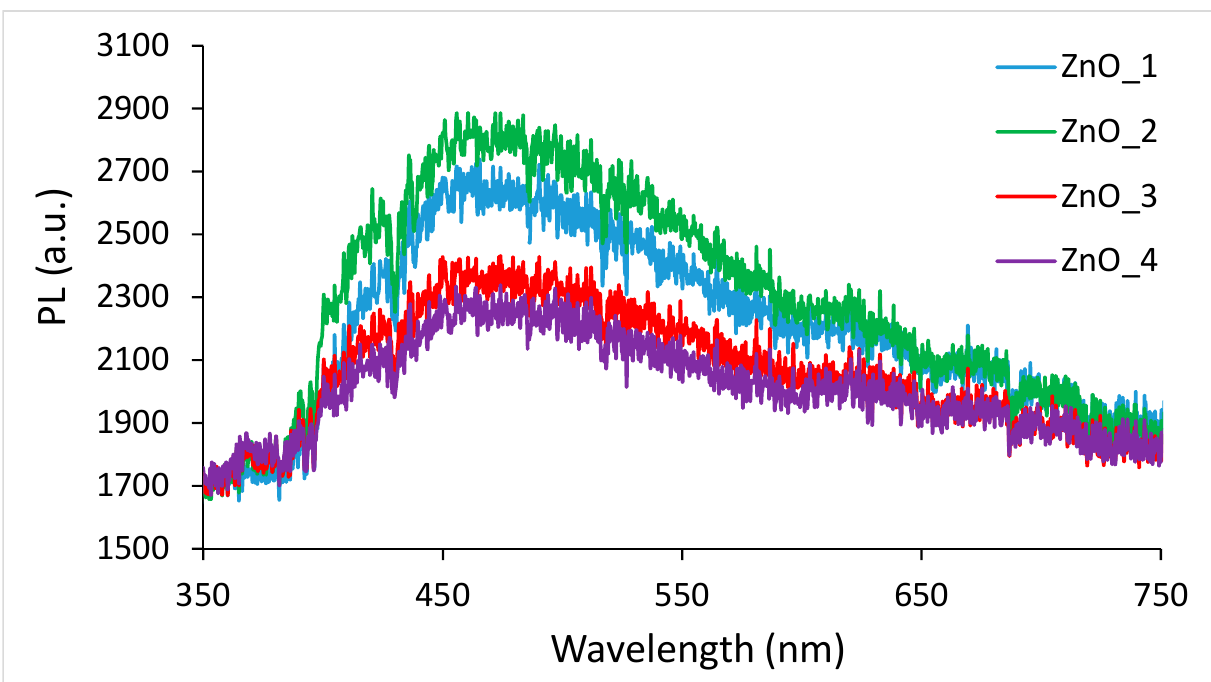
Figure 7. The photoluminescence (PL) spectra of ZnO nanopowders. ZnO_1 = sample synthesized in an alkaline medium without capping agent, ZnO_2 = synthesized in an alkaline medium in the presence of CTABr, ZnO_3 = synthesized in an alkaline medium in the presence of plant extract and ZnO_4 = synthesized only in the plant extract.